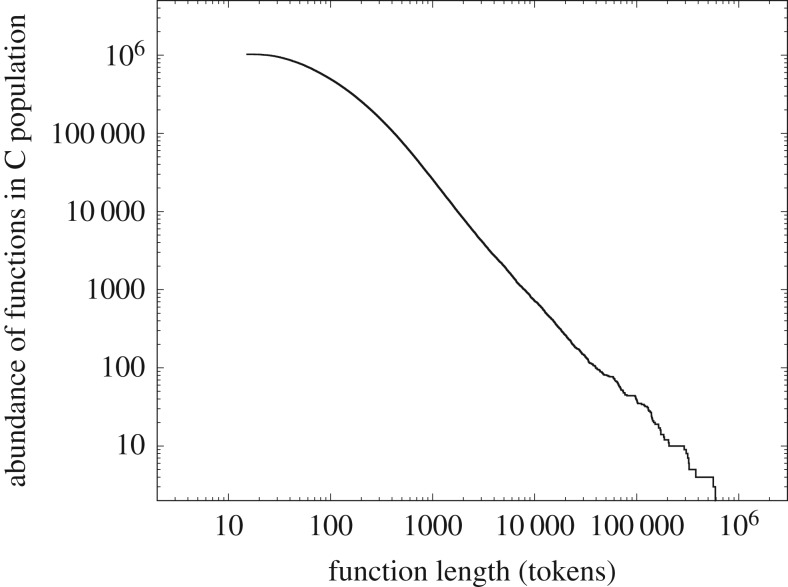
The data of figure 4, the frequency distributions of function lengths, plotted as a ccdf.